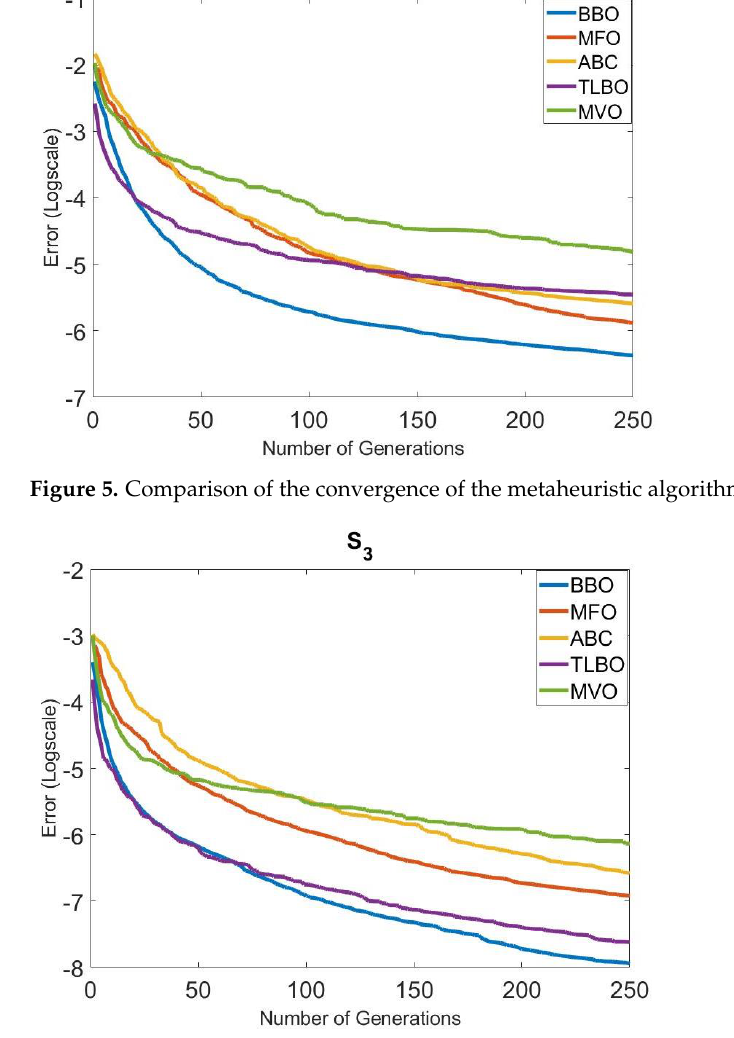
Figure 6. Comparison of the convergence of the metaheuristic algorithms in Group 1 for S 3